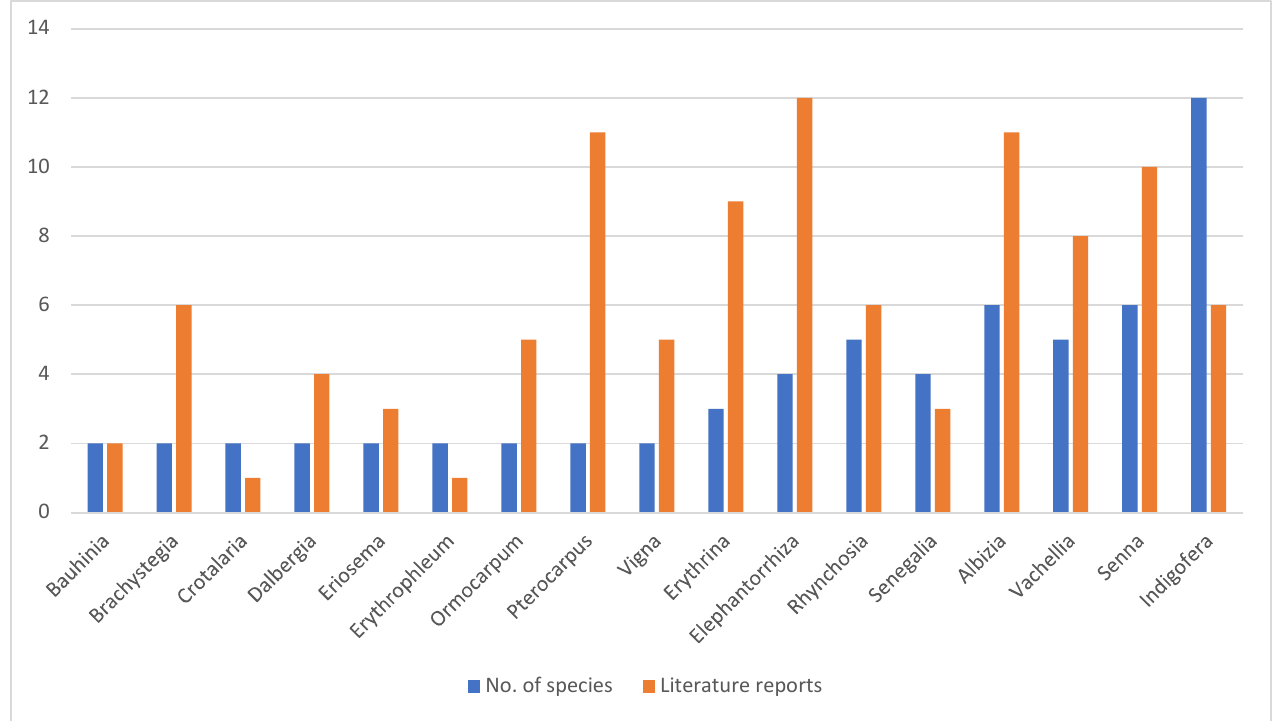
Figure 2. Numbers of species and reports of the use of Fabaceae genera with medicinal uses in